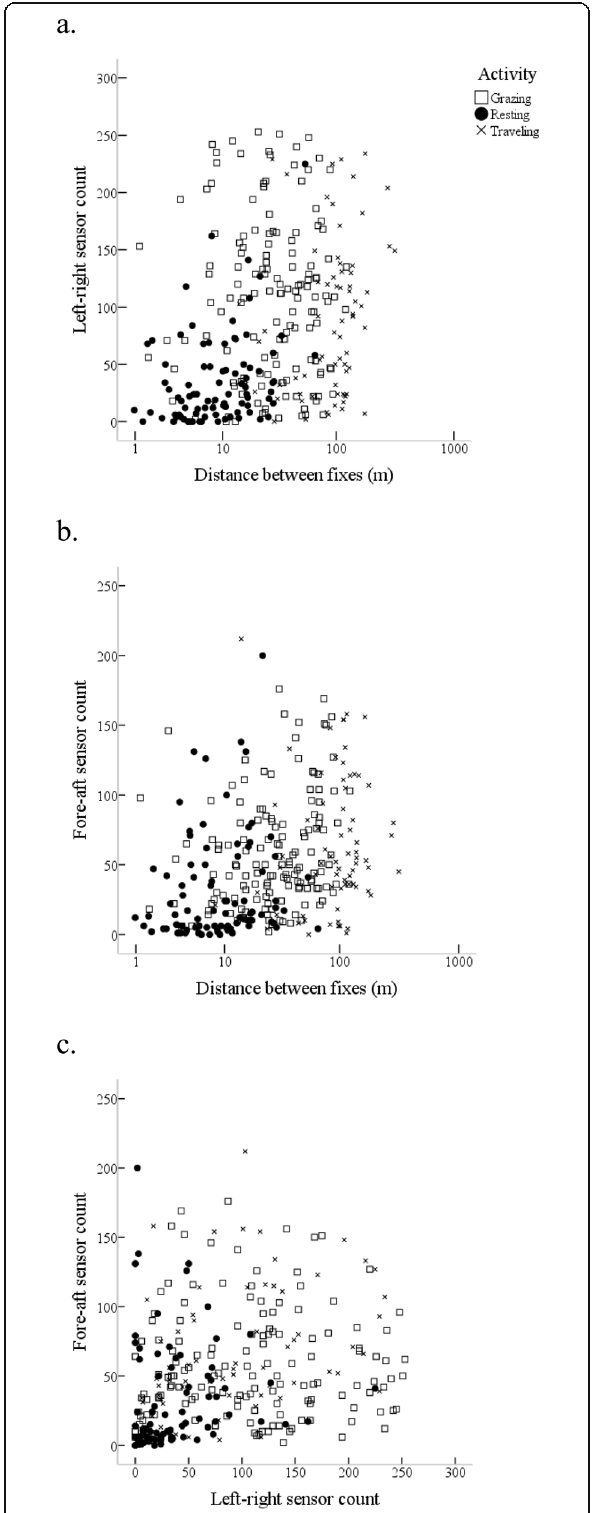
Fig. 2 Relationship between GPS collar variables and cattle activities: grazing, resting, and traveling for Bonsmara cows in South Texas. The graphs show the relationships between distance between GPS fixes and the left-right sensor count ( a ) and fore-aft sensor count ( b ), and the relationship between fore-aft and left-right sensor counts ( c